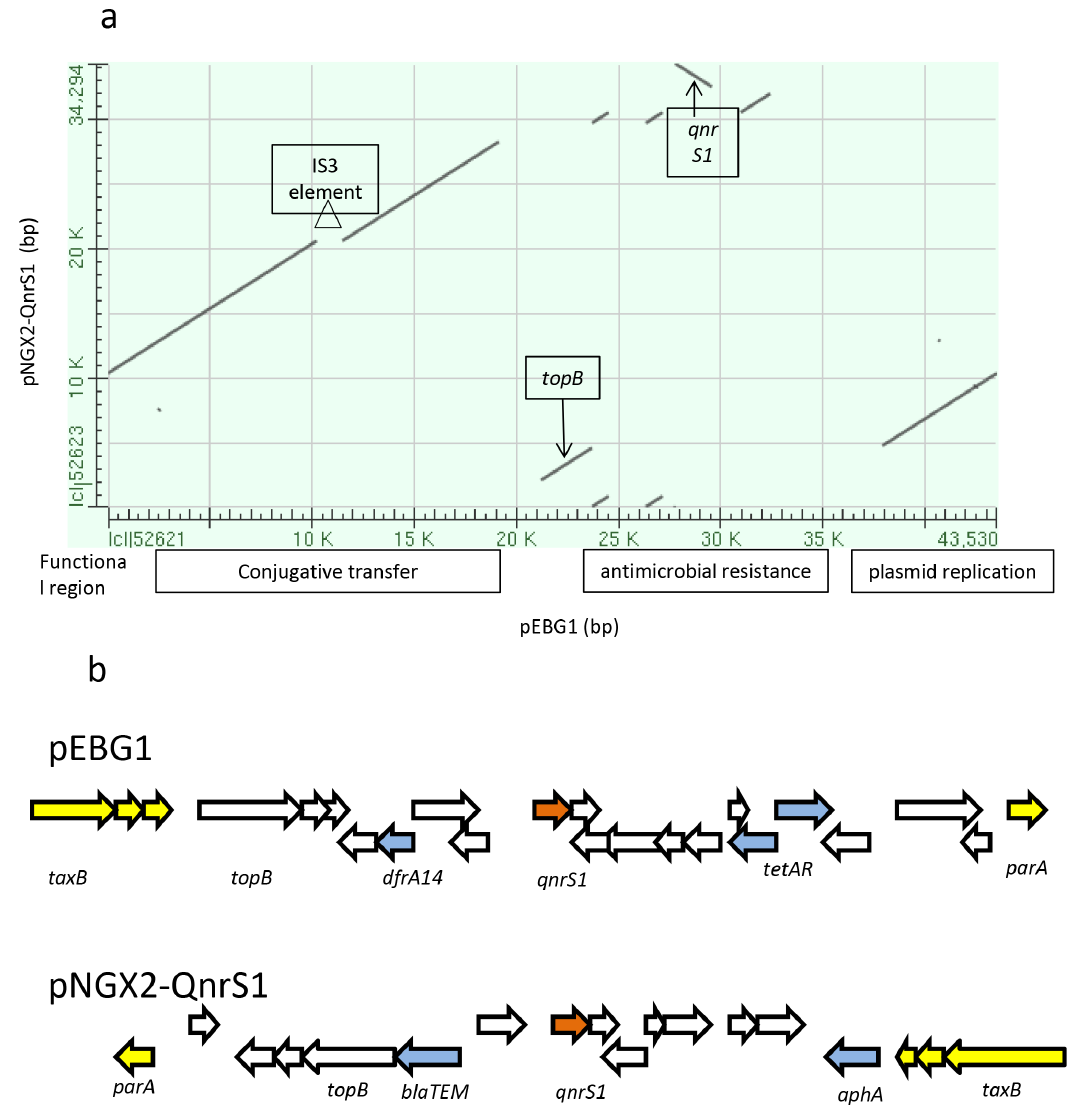
Figure 2. a. Dot plot of pairwise alignment between incX2 plasmids pEBG1 on the x-axis and pNGX2-QnrS1 on the y-axis. The plasmids are highly conserved overall but differ in the location and content of their antimicrobial resistance modules. The pEBG1 conjugation system is interrupted by an IS 3 element not present in pNGX2-QnrS1. b. schematic of the resistance regiosn of plsdmifd pEBG1 and pNGX2-QnrS1. qnrS1 is colored brown and other antimicrobial resistance genes are shaded blue. The flanking core plasmid regions are colored yellow. Note that